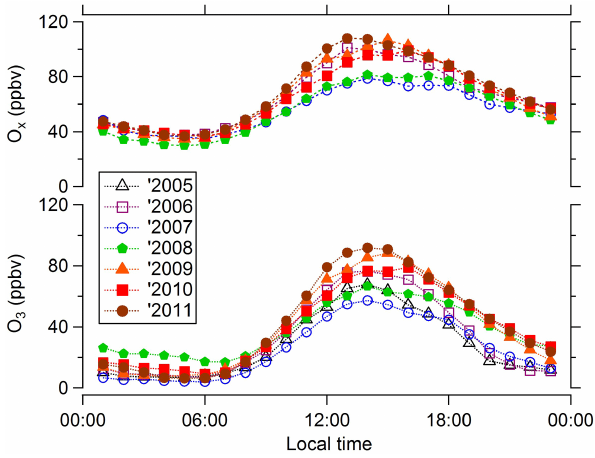
Figure 2. Diurnal variations of O x (upper) and O 3 (lower) in Bei- jing, August between 2005 and